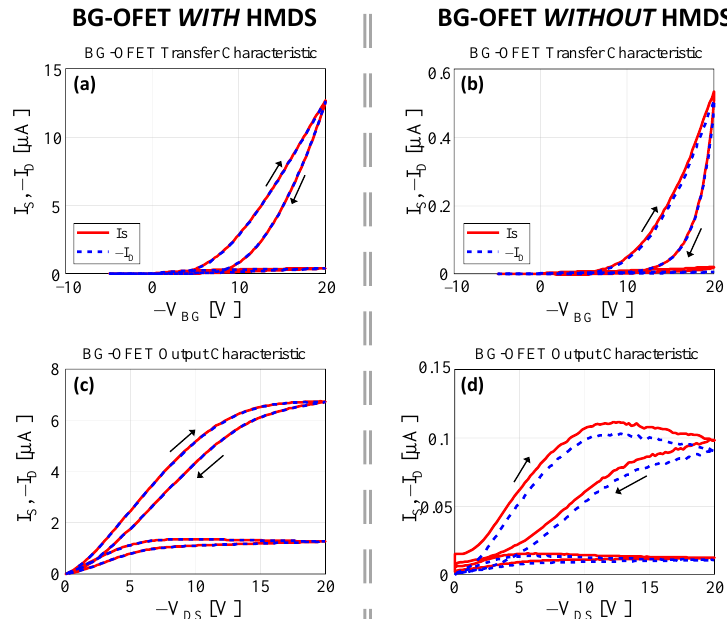
Figure 3. BG-OFETs characterizations with and without HMDS functionalization: ( a ) Transfer characteristics with HMDS; ( b ) transfer characteristics without HMDS; ( c ) output characteristics with HMDS; ( d ) output characteristics without HMDS. Discrepancies between the source (I S ) and drain (I D ) currents are due to BG leakage current (see Supplementary Figure S3).